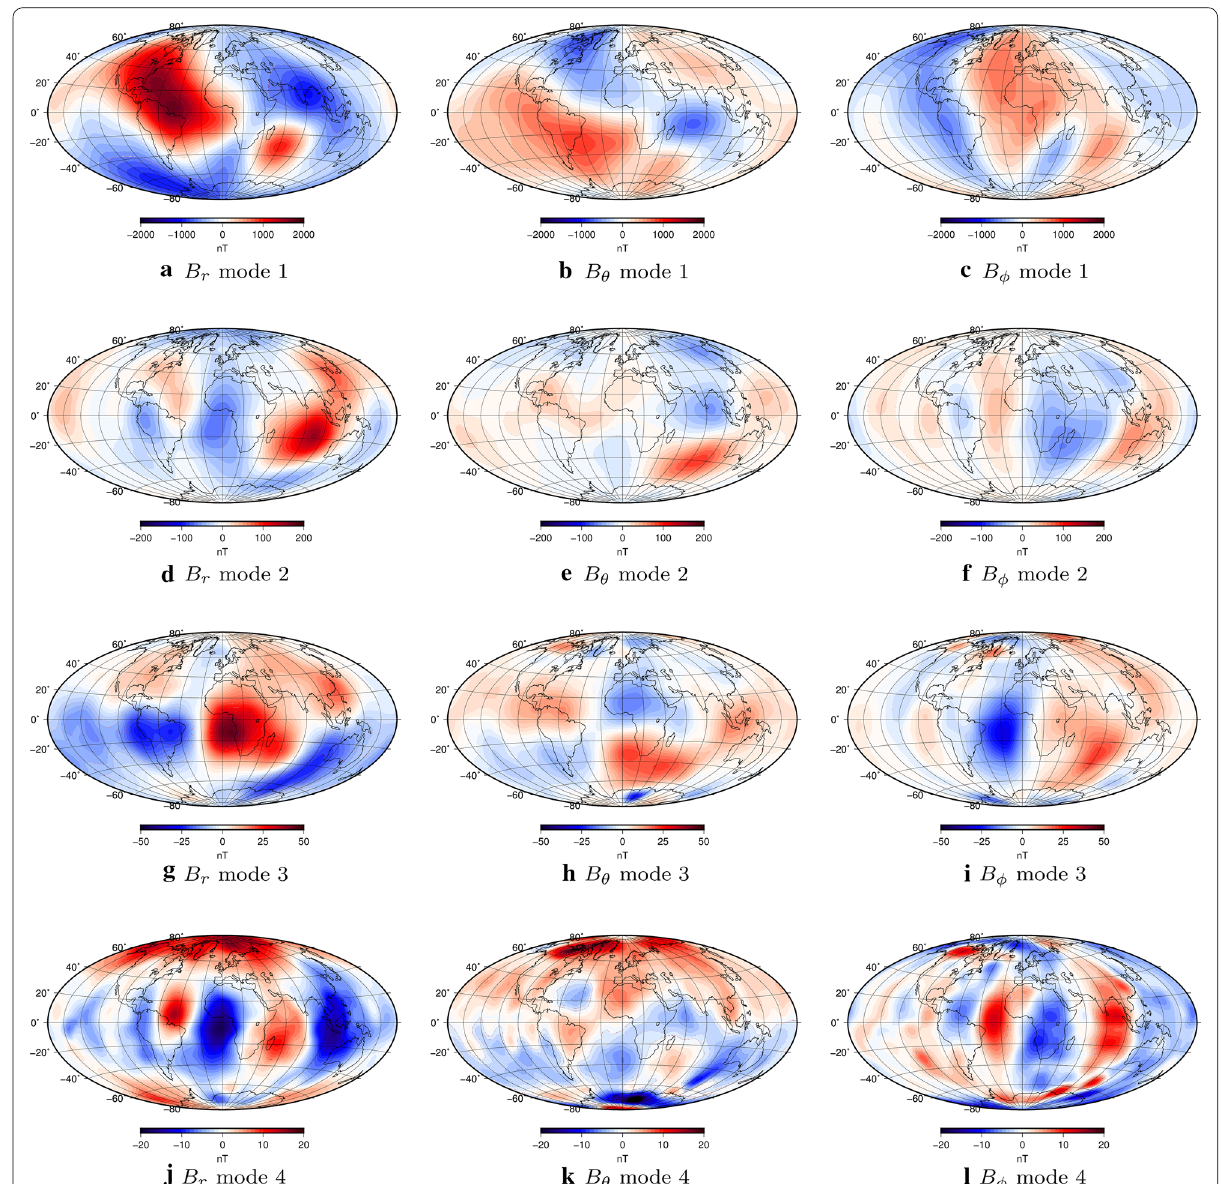
Fig. 4 Charts representing the scaled spatial features ( α j p j , see Eq. (2)) on the global grid for the first four PCA modes, using data from CHAMP. Each vectorial mode is characterised by the three charts B r , B θ and B